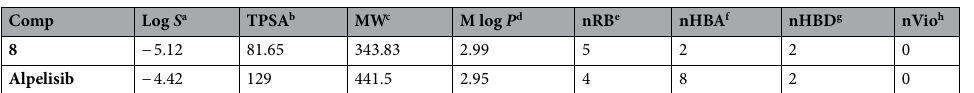
Table 7. Solubility, topological surface area and calculated Lipinski’s rule of five for compound 8 and Alpelisib. a Solubility parameter. b Topological polar surface area (Å 2 ). c Molecular weight (g/mol). d Lipophilicity parameter. e Number of rotatable bonds. f Number of hydrogen bond acceptors. g Number of hydrogen bond donor. h Number of violations to Lipinski’s rule of